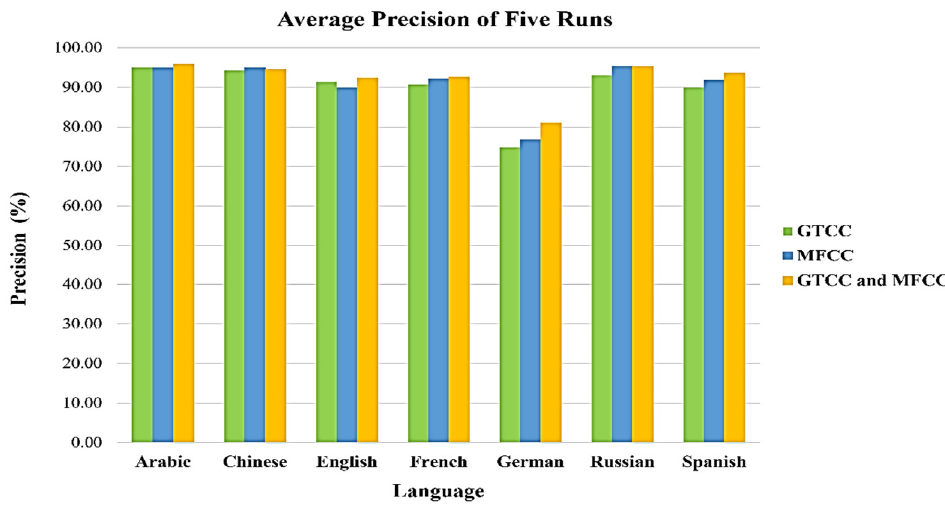
Figure 4. The average precision of each feature.